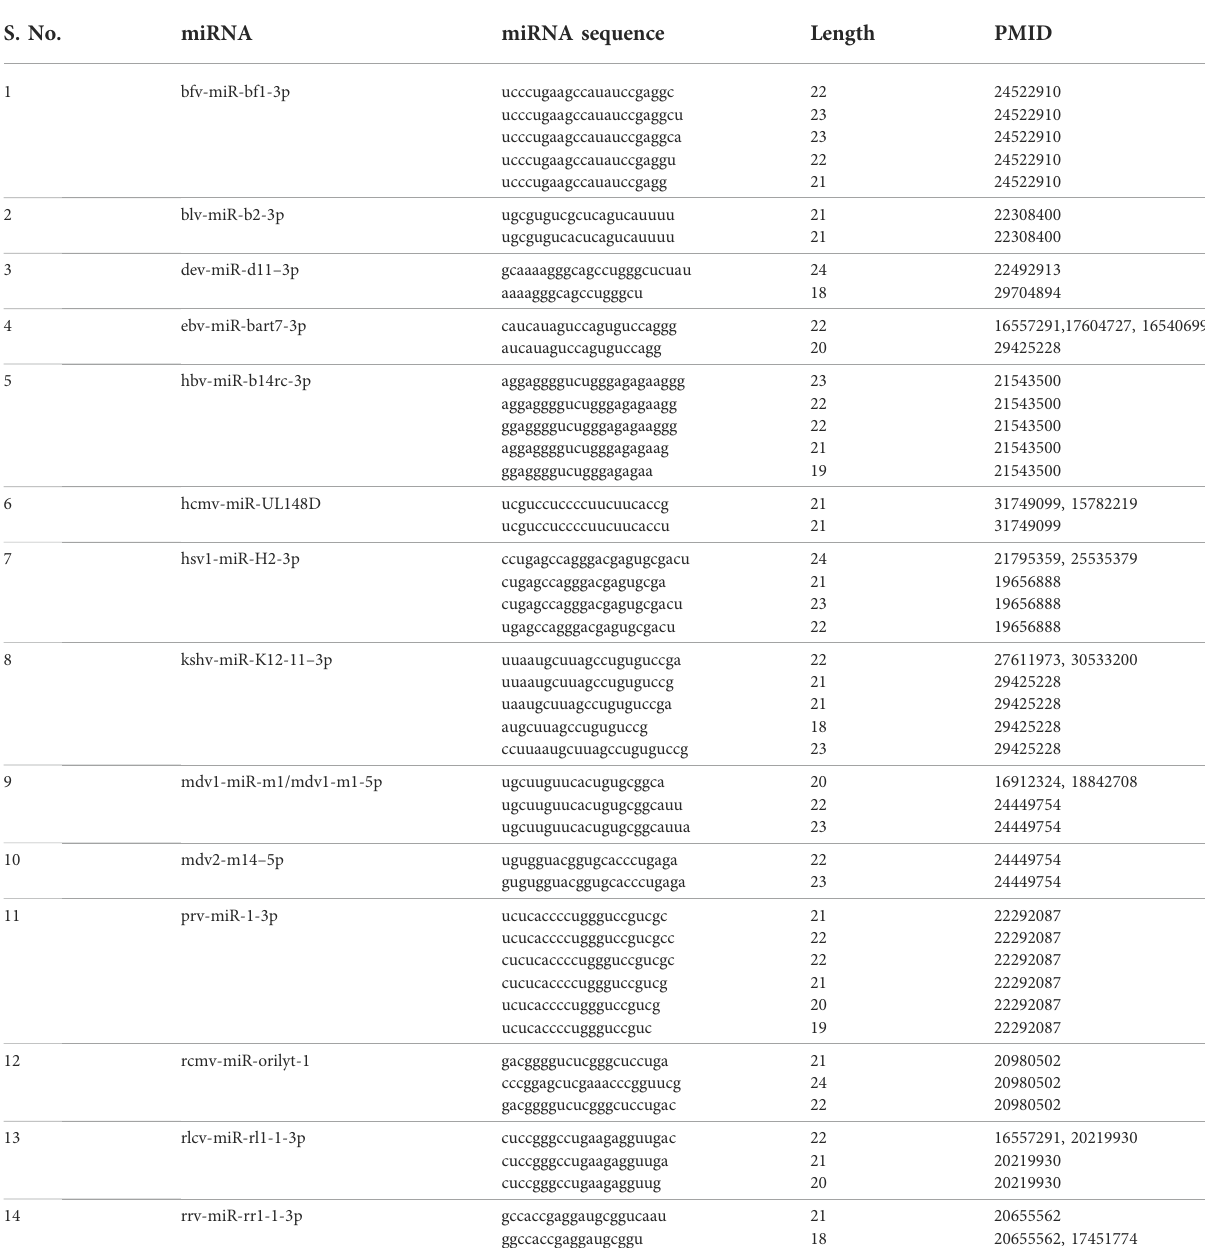
TABLE 1 Representative isomeric miRNA sequences for 14 viruses. S.